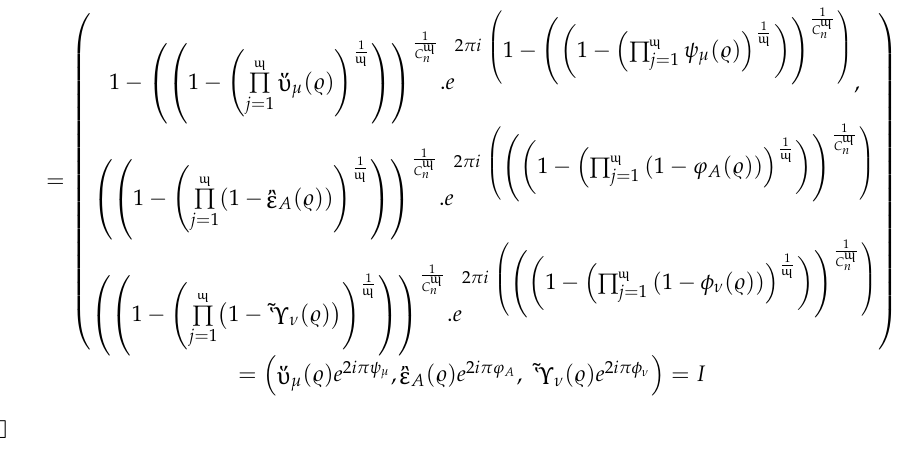
Table 1. Symbols and their meanings. Symbols Meanings Symbols Meanings